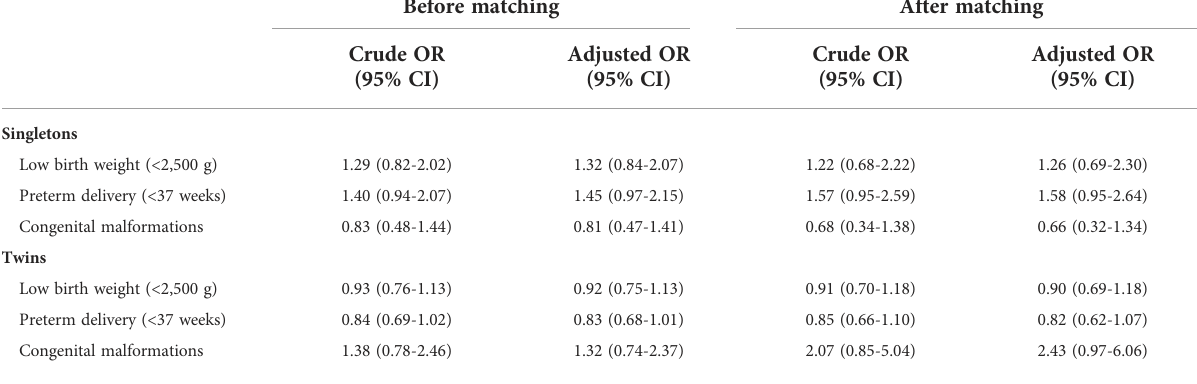
TABLE 4 Crude and adjusted odds ratios (ORs) of neonatal outcomes in live-born singletons and twins between the PPOS and GnRH-ant groups. Before matching After